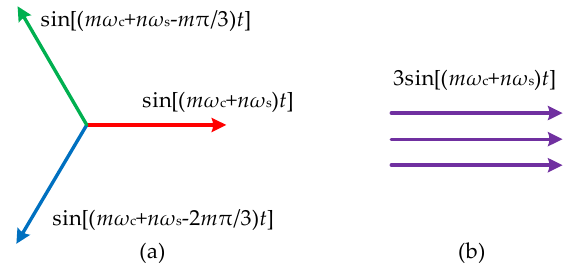
Figure 3. Sideband harmonic vectors when N = 3. ( a ) m ≠ 6 k , and ( b ) m = 6 k.